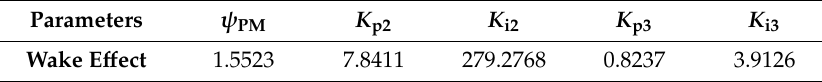
Table 9. Identification results when wind speed is